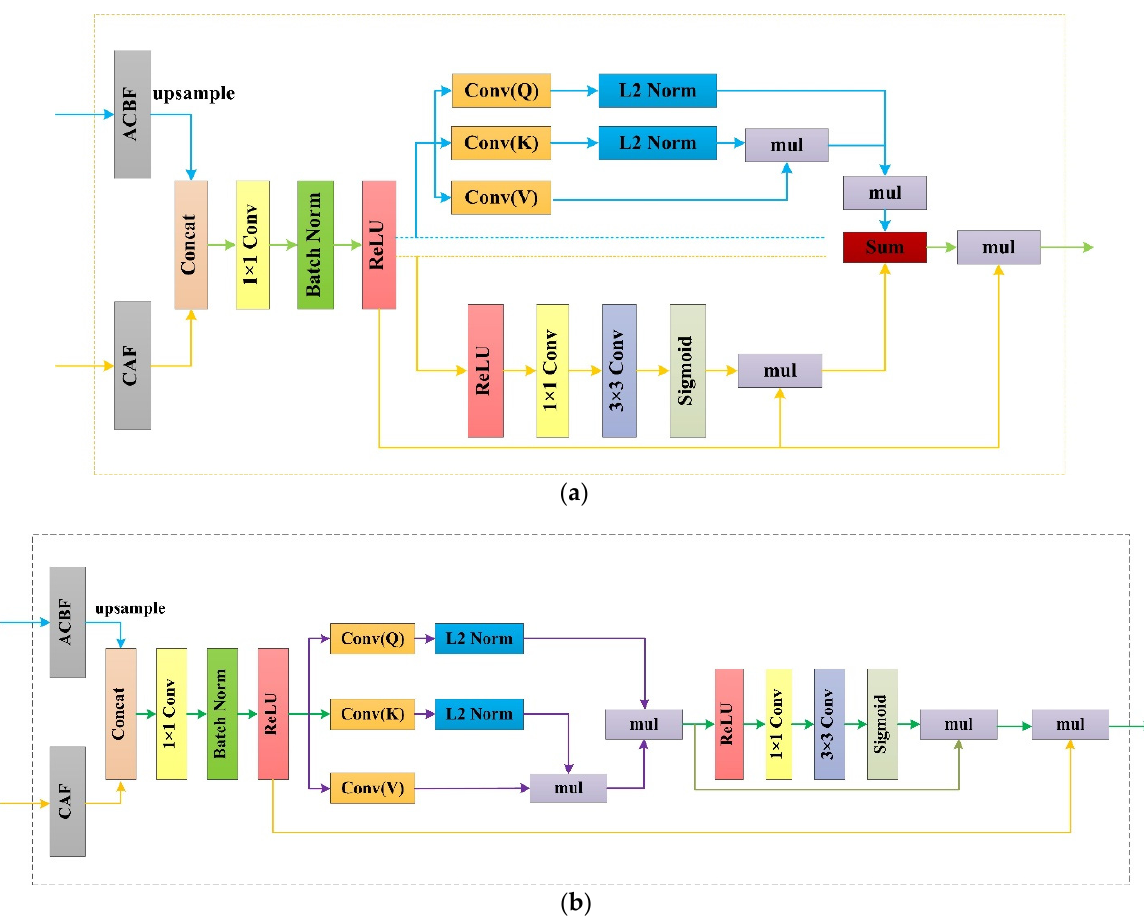
Figure 7. The structures of the RFB. ( a , b ) represent respectively parallel and serial connections, namely, RFB(V) and RFB(H).